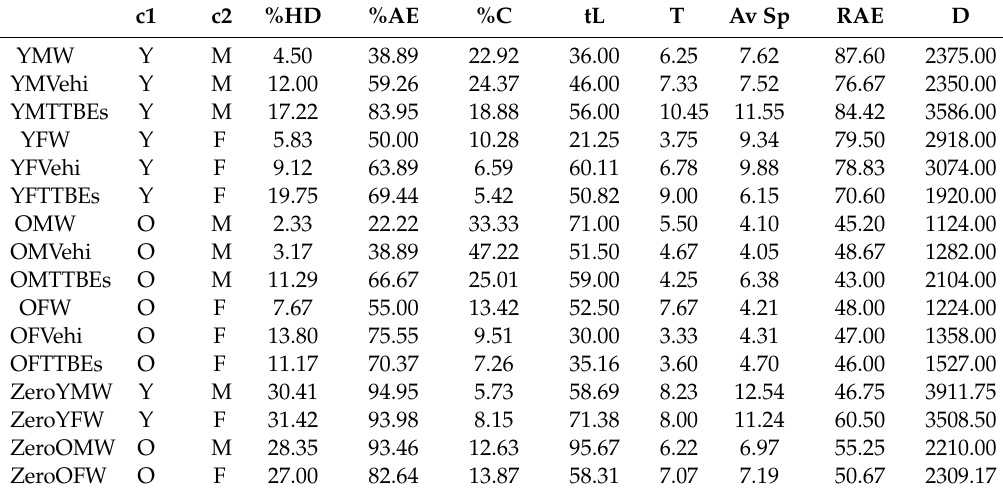
Table 3. Data matrix D 16,8 : 16 animal groups, classified both by age (c1) and gender (c2), and the 8 behavioral